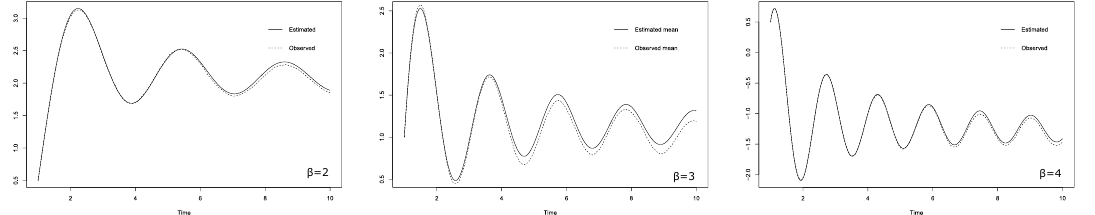
Figure 4. Simulated and estimated mean functions for variations of parameters of Table